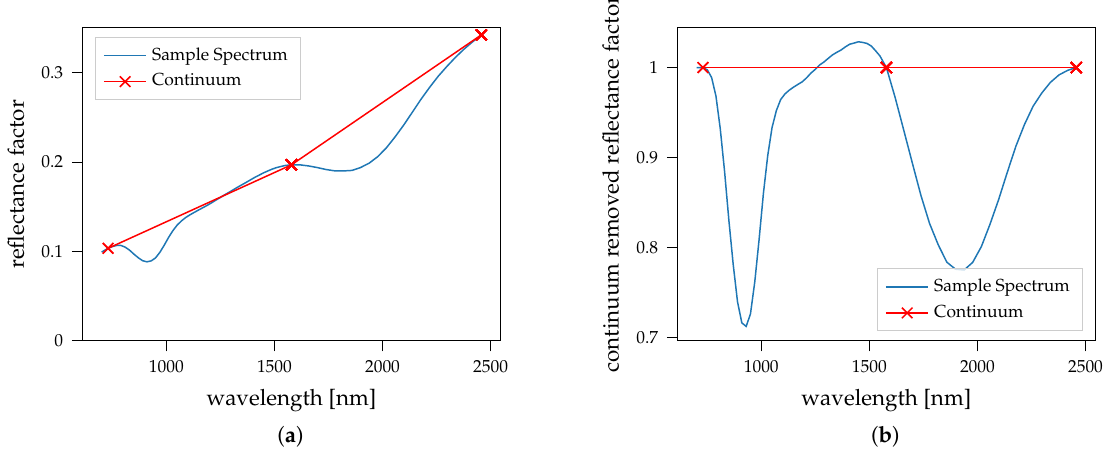
Figure 3. Example calculation of the continuum removed spectrum for endmember AG-TJM-009 from the RELAB database space weathered with 1.5wt.% npFe 0 and 0.8wt.% mpFe. The continuum is calculated as the linear interpolation between the reflectance factor at 730.48 nm, 1578.86 nm and 2497.11 nm. These channels usually lie outside the absorption bands. ( a ) Reflectance spectrum; ( b ) continuum removed